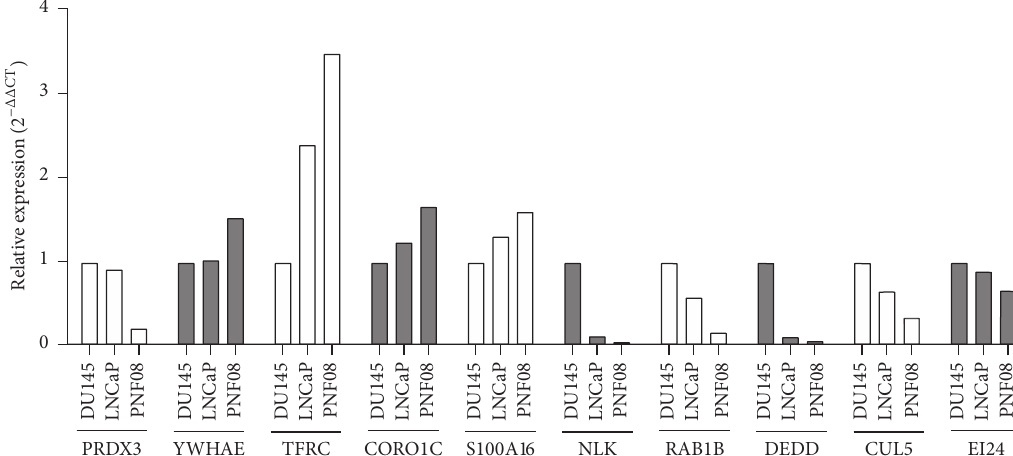
Figure 1: Quantification of mRNA expression in primary normal prostate (PNF-08) cells and the DU145 and LNCaP PCa cell lines. The expression of ten mRNAs that were assumed to be elevated or reduced according to their presence or absence in the Ago complex was assessed by qRT-PCR. YWHAE, TRFC, CORO1C, and PRDX3 were predicted to be elevated while, NLK, RAB1B, DEDD, CUL5, EI24, and S100A16 were predicted to be reduced in PCa cells as compared to PNF-08